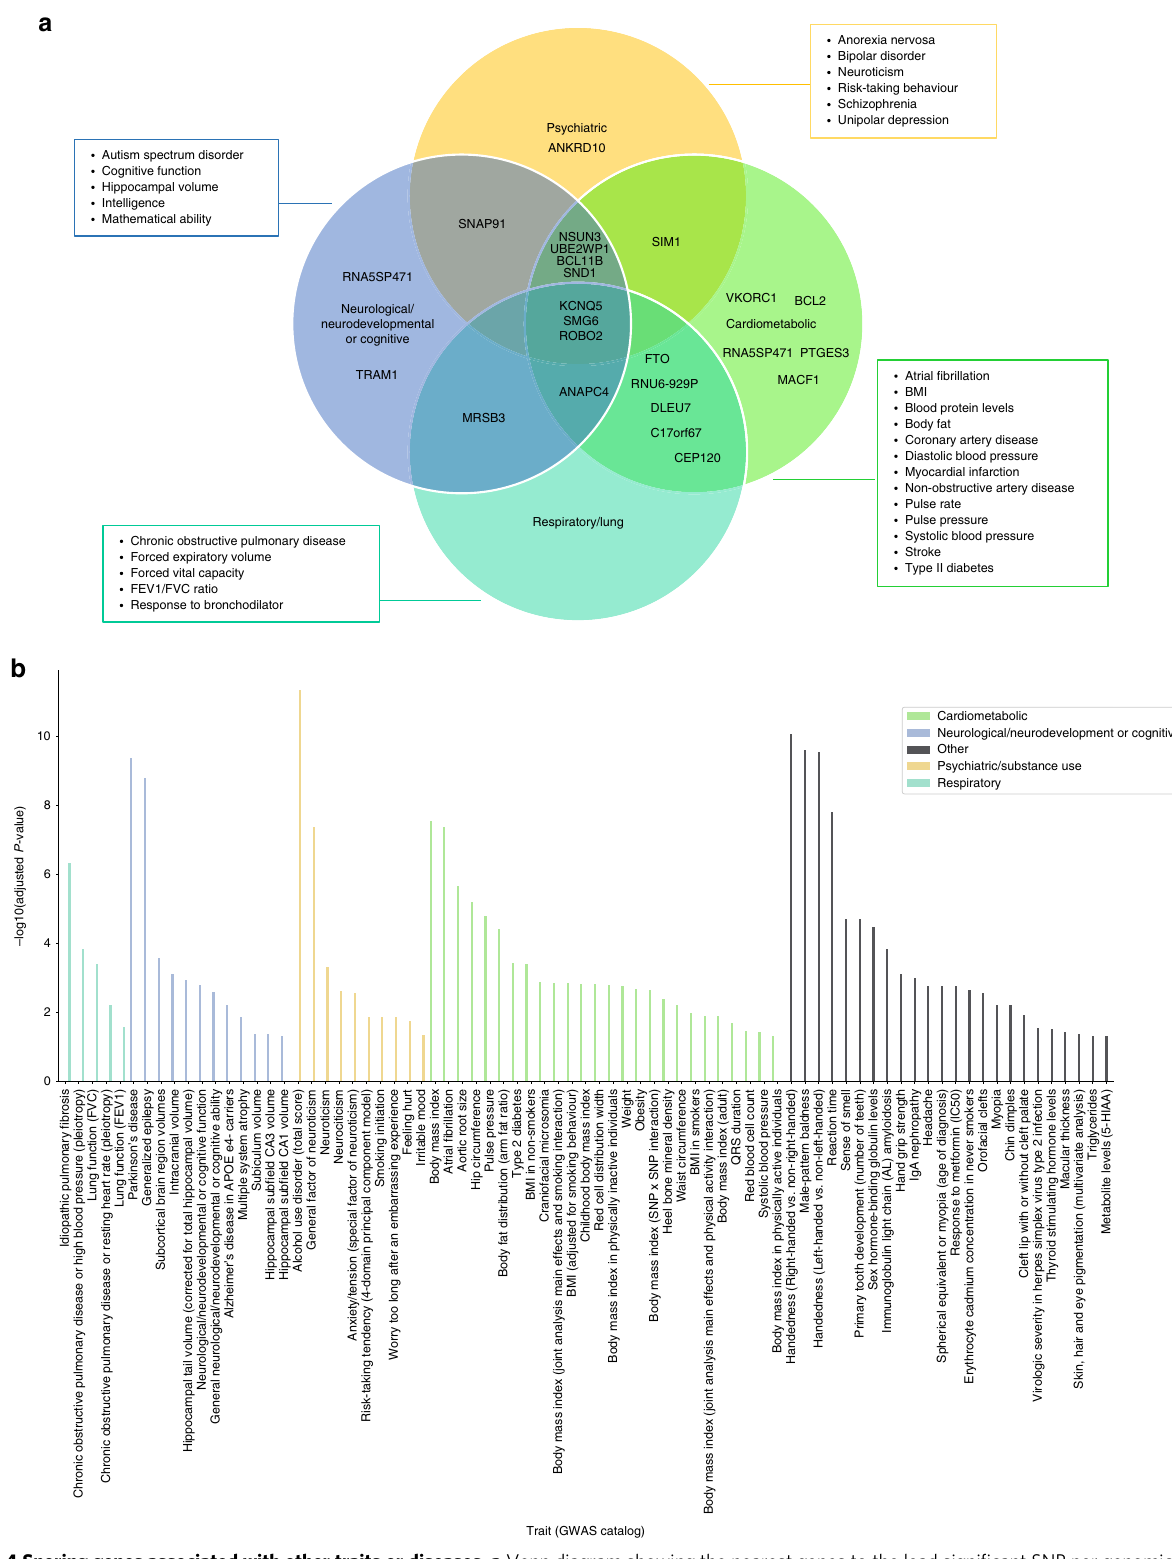
Fig. 4 Snoring genes associated with other traits or diseases. a Venn diagram showing the nearest genes to the lead signi fi cant SNP per genomic risk loci identi fi ed for snoring, categorized according to previously reported association with other traits or diseases in the GWAS catalogue. b Signi fi cant gene-set enrichment analysis (hypergeometric test) based on all prioritized genes against gene sets de fi ned by traits in the GWAS